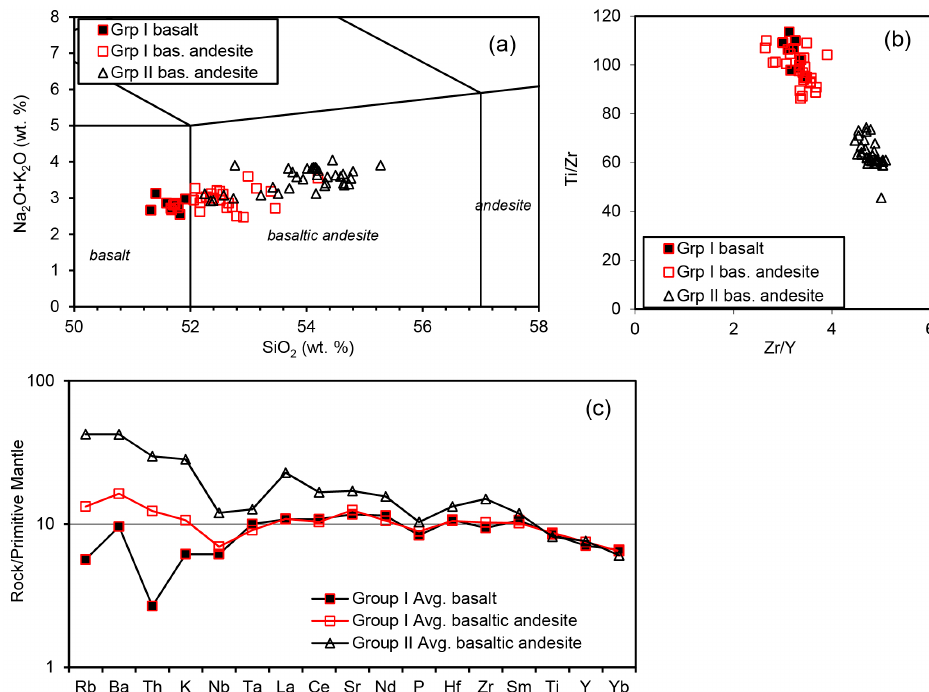
Figure 3. Bulk chemical compositions of the Rajmahal basalts and basaltic andesites (data from [10,21]). ( a ) Total alkali versus SiO 2 after [44]. ( b ) Ti/Zr versus Zr/Y. ( c ) Primitive mantle-normalized [45] incompatible elements.